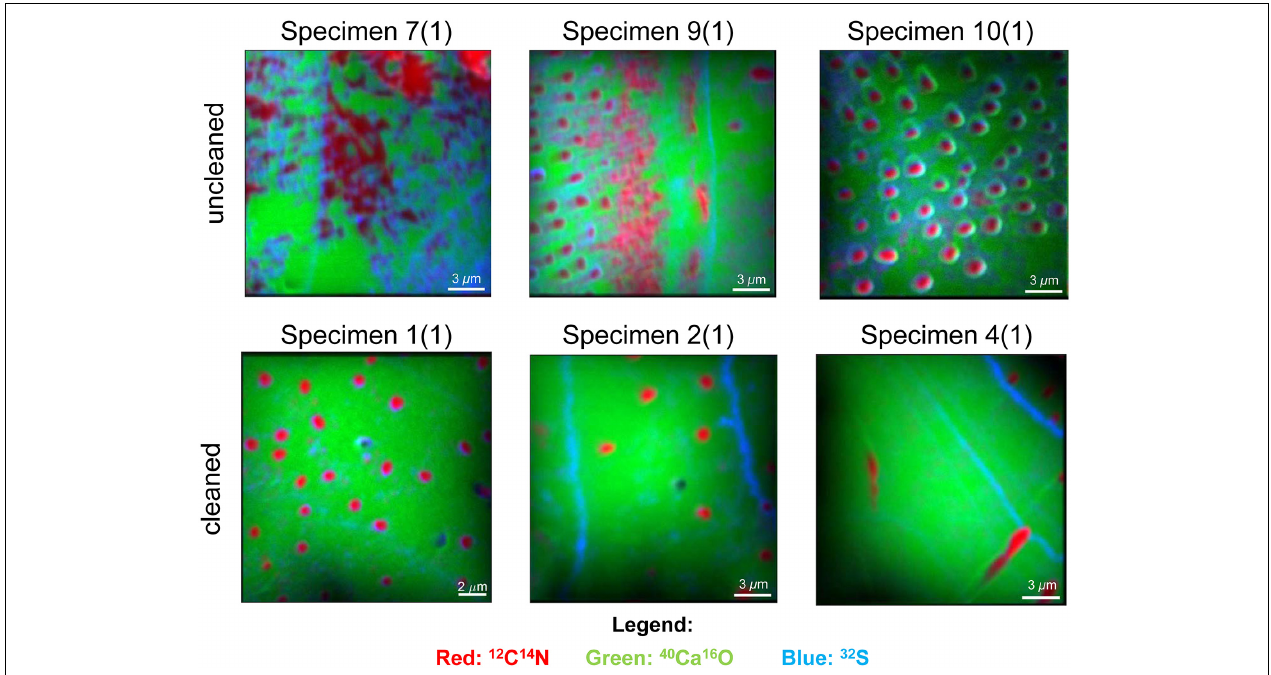
FIGURE 3 | Red–Green–Blue pictures of six NanoSIMS mappings on cross-sections of three different uncleaned U. striata specimens and three specimens that have been treated by an oxidative cleaning before embedding for the preparation of the cross-sections. The distribution of 12 C 14 N − is indicated in red, 32 S − is marked in blue, and 40 Ca 16 O − is marked in green. 12 C 14 N − is a tracer for hotspots of organic matter and also enriched within the test pores of the foraminifers. Blue bandings indicate discrete 32 S − bandings and likely indicate the position of the original primary organic membrane (POM). Bright green areas indicate regions of “pristine” CaCO 3 with low content of organic matter. Note the strong impact of cleaning on the distribution of the organic matrix within the foraminiferal calcite. Note that the mappings shown here were located within the foraminiferal calcite, showing no signal from the resin.